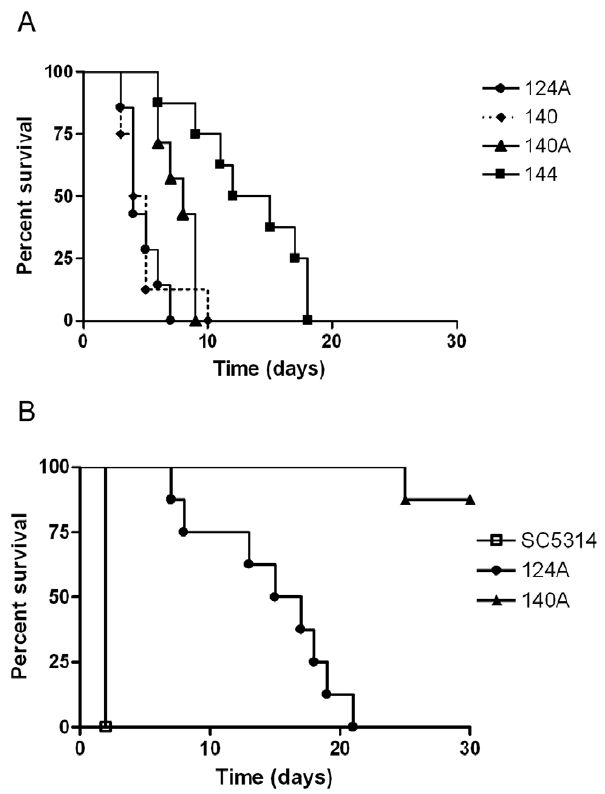
Figure 2. Survival of BALB/c mice following i.v. infection with C. albicans strain variants. Mice were infected i.v with (A) 2 6 10 6 cells of isolates 124A, 140, 140A or 144 or (B) 1 6 10 6 cells of SC5314, 124A or 140A and the condition of the mice were assessed daily for 30 days.